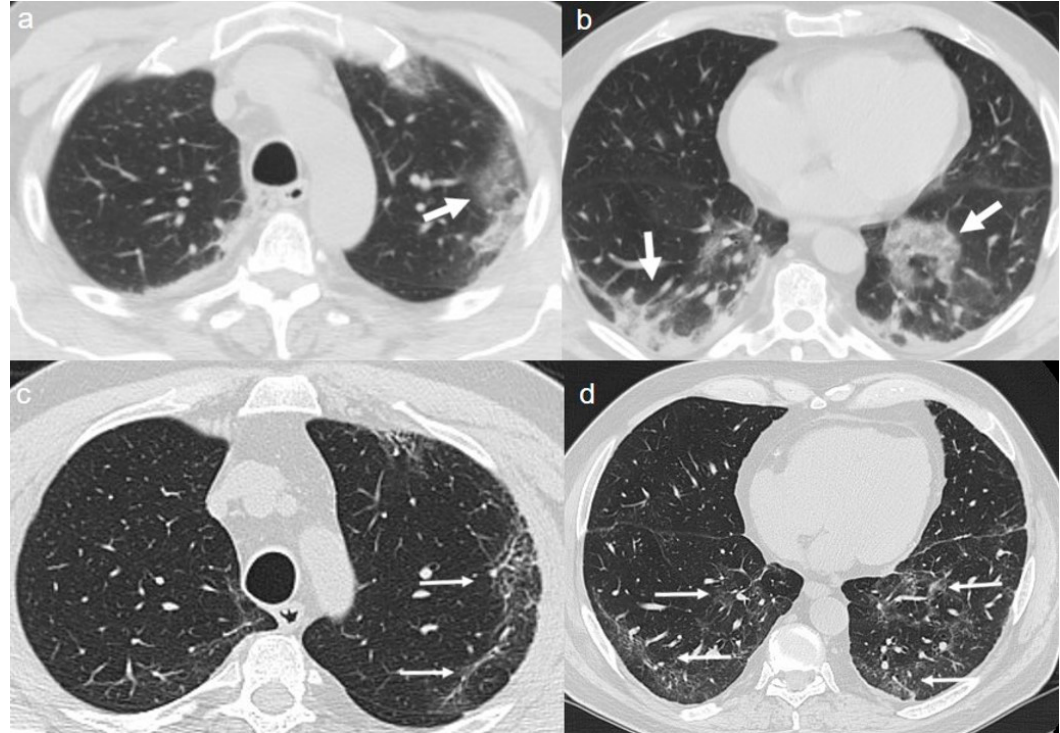
Figure 6. ( a , b ) CT shows a “crazy paving pattern” peripherally located in the upper left lobe (arrow in a ) and in the lower lobes (arrows in b ). ( c , d ) CT after 4 months from the onset of symptoms shows persistence of mixed pattern characterized by interlobular septal thickening (thin arrows in c ) and patchy GGOs (thin arrows in d ).